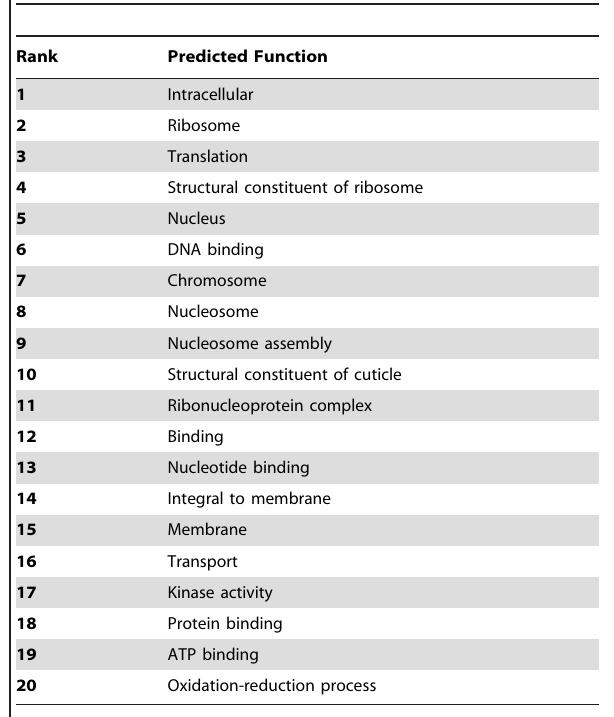
Table 3. Top 20 gene functions of insect genes that are associated with biased synonymous codon usage orders (SCUO . 0.5).